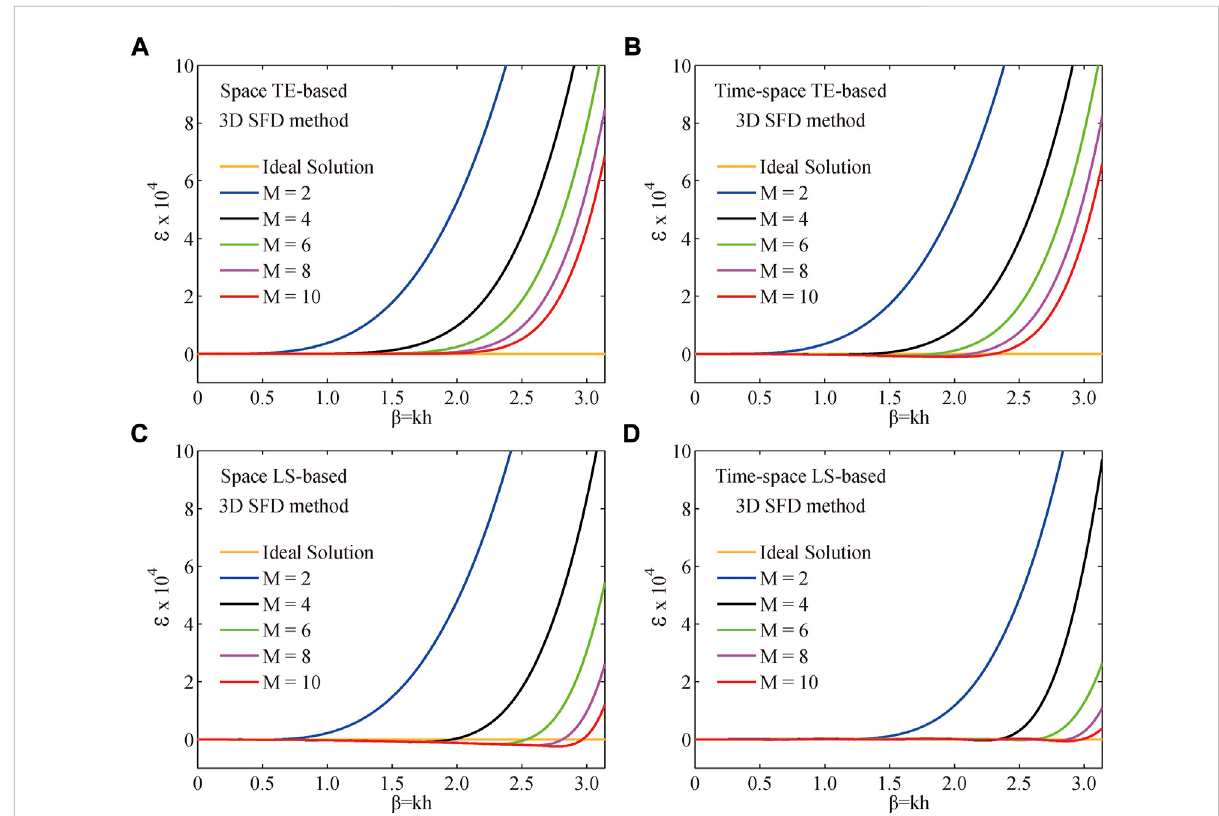
FIGURE 1 Variation curves of numerical dispersion ( ε ) with the difference operator length ( M ) changing for the simple 3D homogeneous acoustic model (Model A). These subgraphs (A – D) indicate different 3D SFD methods listed in